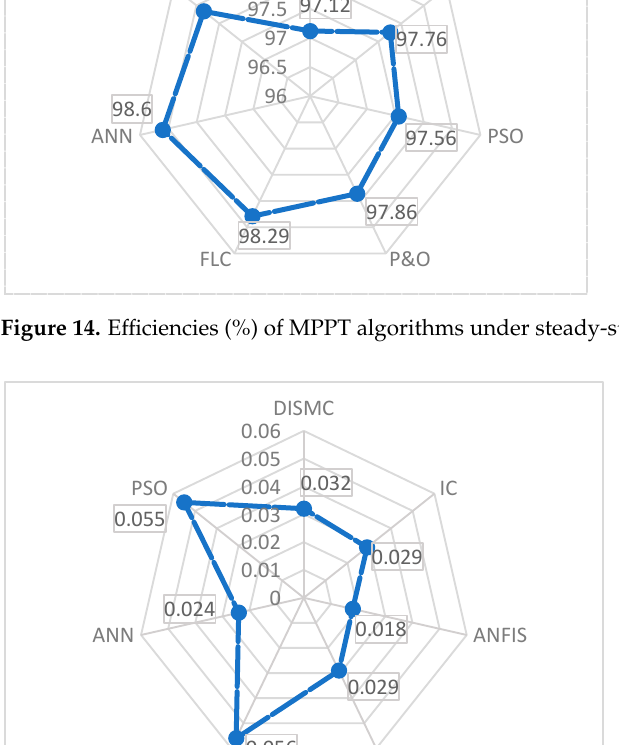
Figure 14. Efficiencies (%) of MPPT algorithms under steady-state weather conditions: Test 1.